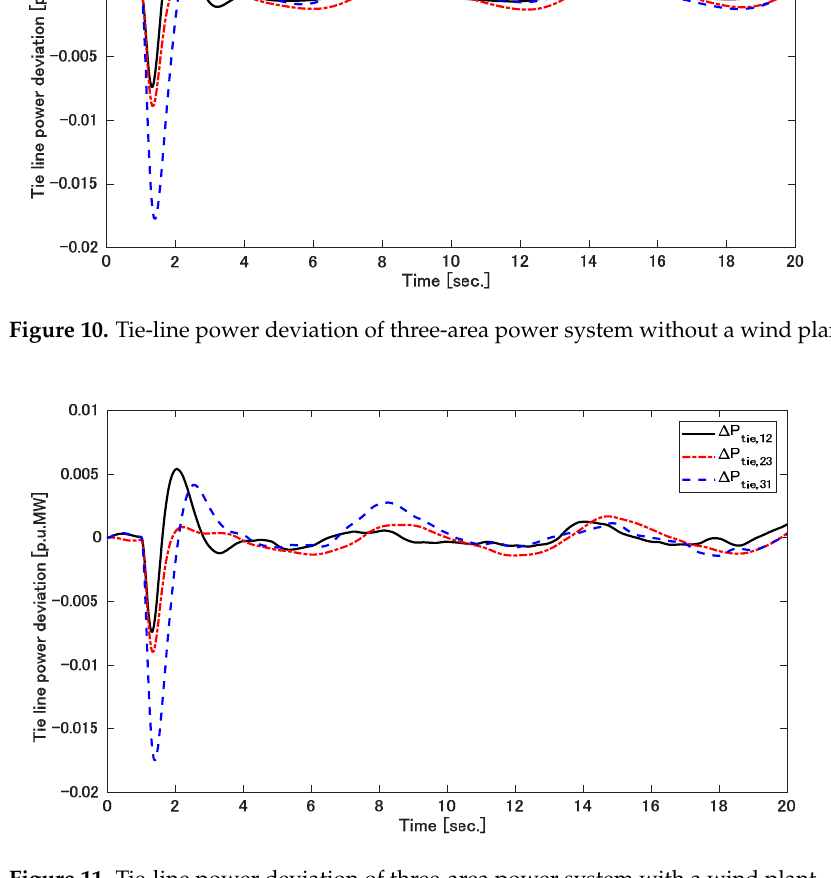
Figure 11. Tie-line power deviation of three-area power system with a wind plant.